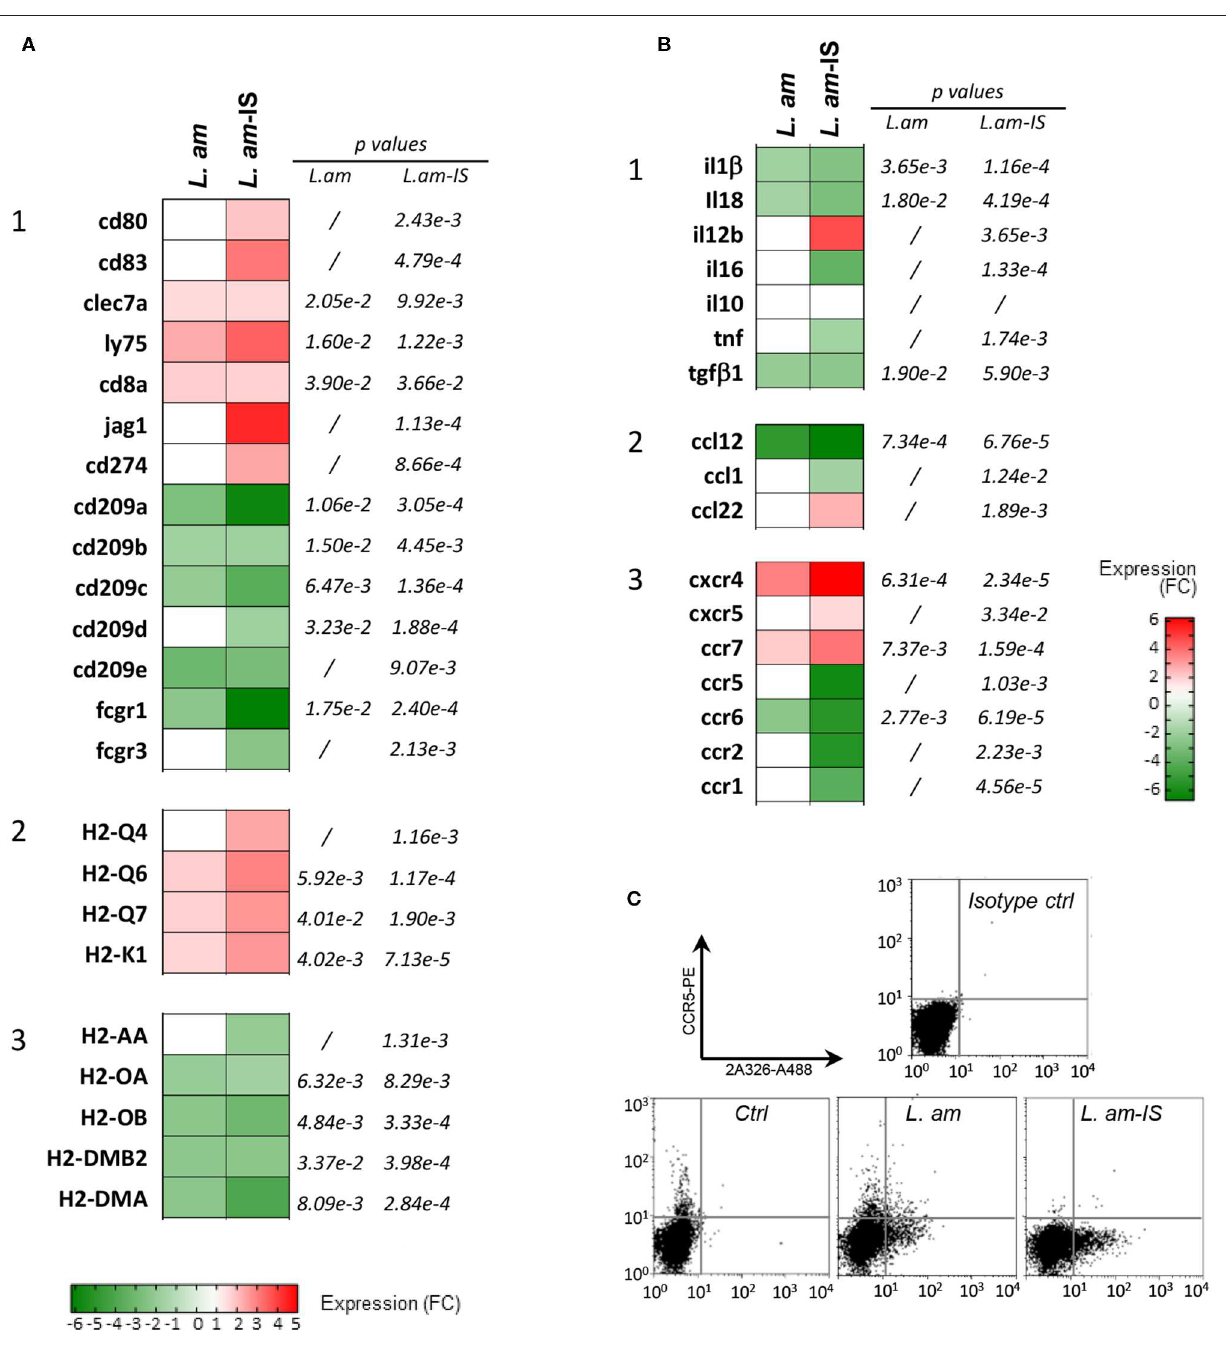
Frontiers in Immunology |